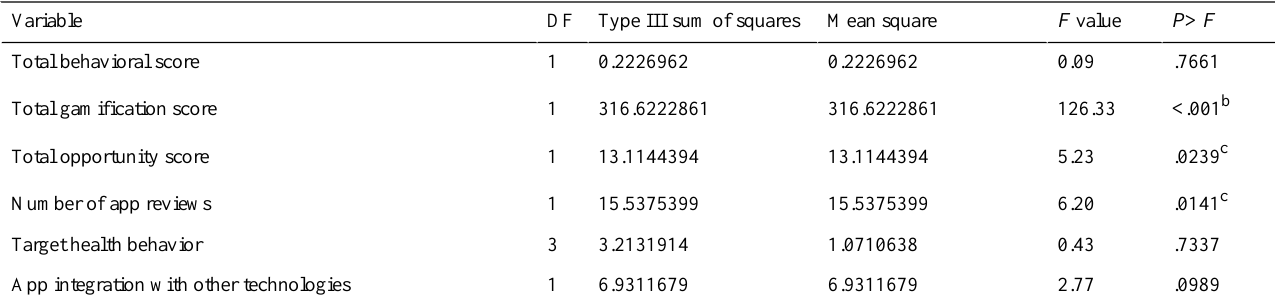
P > FF valueMean squareType III sum of squaresDFVariable